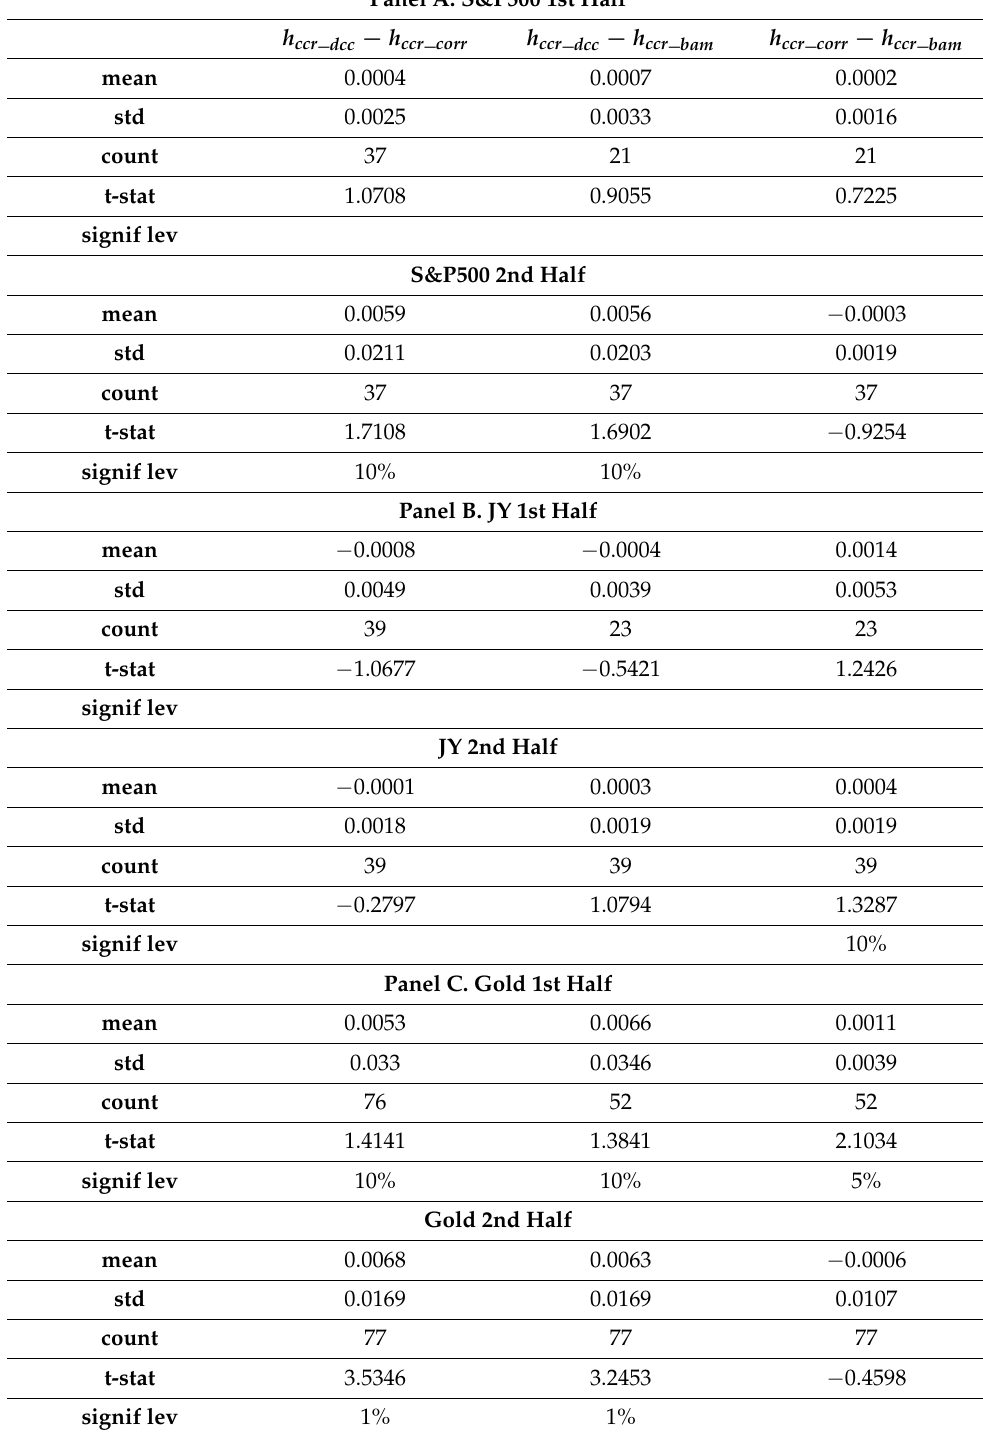
Table 5. Stability of the HE Differences across h ccr Bias-Adjustment